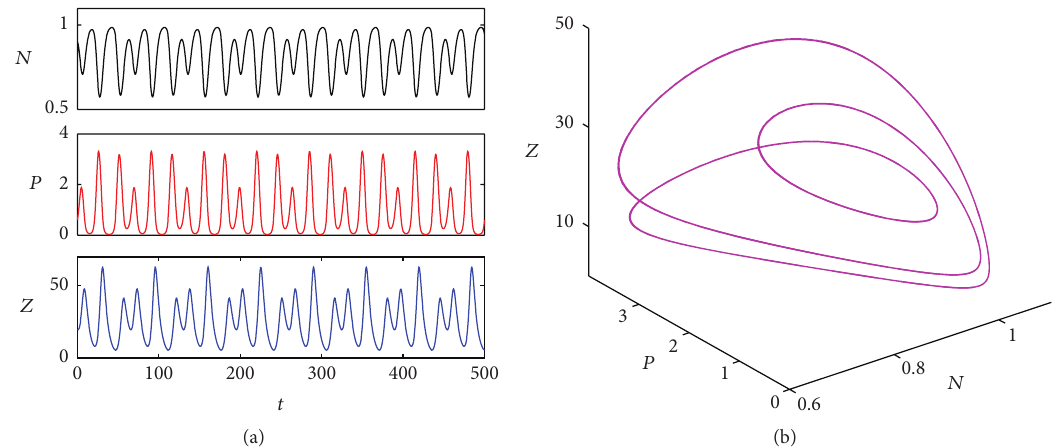
Figure 4: Numerical solutions of system (3) with 𝛼 = 0.4 , 𝜏 = 50 , and initial point (0.8, 1, 18). (a) shows the time series of 𝑁 (black line), 𝑃 (red line), and 𝑍 (blue line) and (b) shows the associated phase diagram of system (3) (magenta line). There exists a positive period-3 solution of system (3).